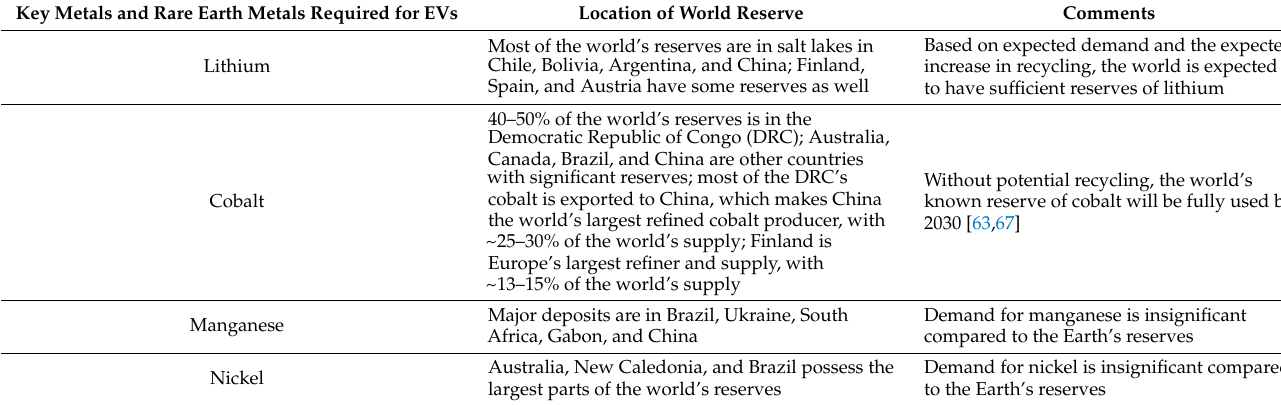
Table 2. Active metals in lithium-ion battery cells